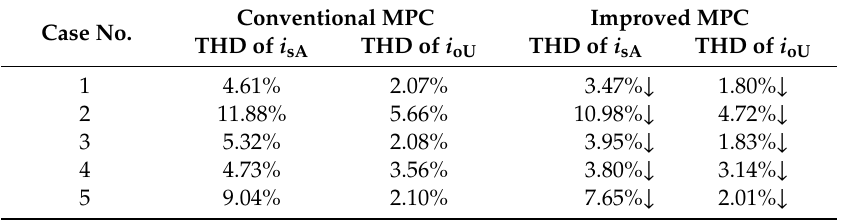
Table 5. Total harmonic distortions (THDs) of source and output currents at steady state. Case